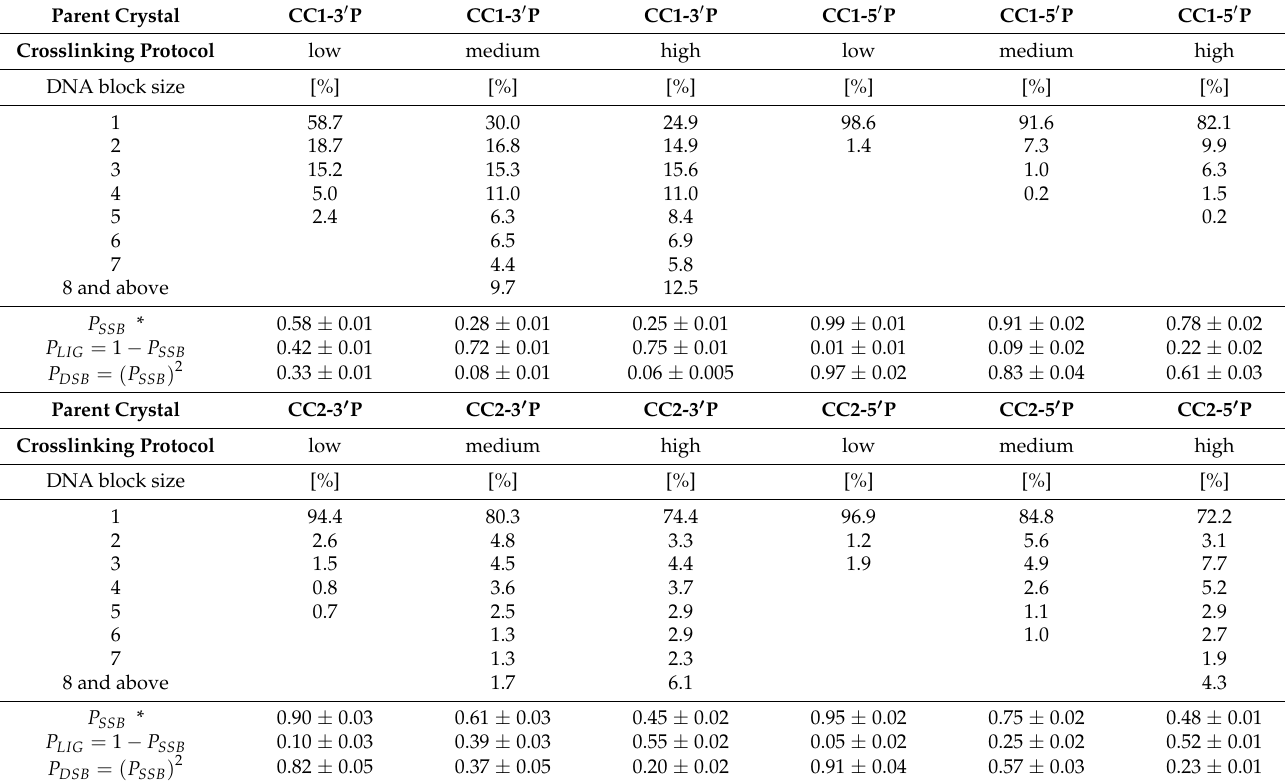
Table 4. Distribution of DNA block sizes as a function of crosslinking protocol and 3 (cid:48) vs. 5 (cid:48) terminal phosphates. The data shown correspond with the gel lanes in Figure 4. The crosslinking protocols low, medium, and high were 1 dose of 5 mg/mL EDC for 12 h, 1 dose of 30 mg/mL EDC for 12 h, and 2 doses of 30 mg/mL EDC for 12 h each, respectively. The values in this table are weighted so that the DNA length and dye intensity contributes to the final value. Unweighted values are found in Table S2. The full table, including estimated mole fractions for higher-order products, is found in Table S3. P SSB , P LIG , and P DSB were calculated for each crosslinked crystal sample. Uncertainties are standard deviations in derived quantities after 500 trials in which noise (standard deviation 0.03) is introduced into relative band